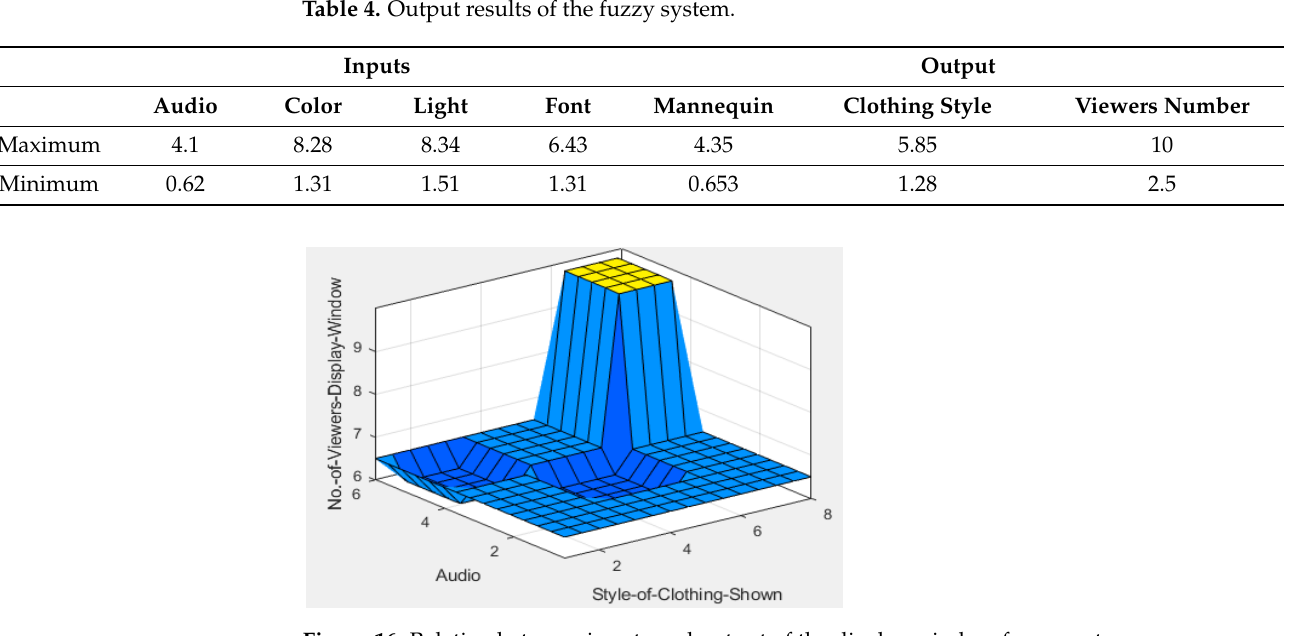
Figure 16. Relation between inputs and output of the display window fuzzy system. Table 5. Error rate and accuracy of inputs and